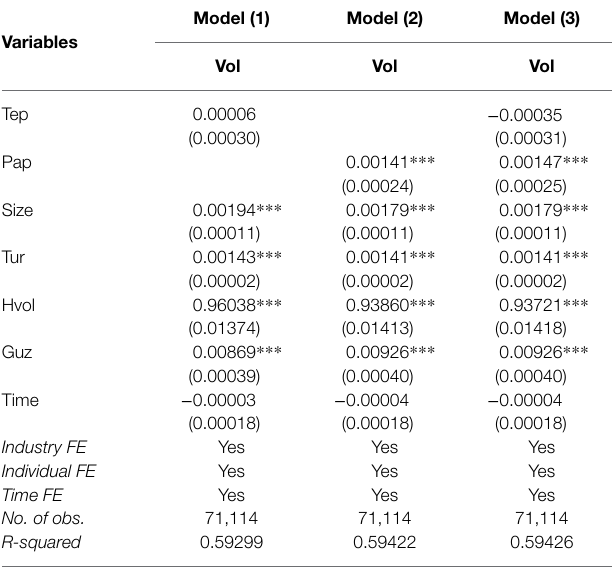
TABLE 4 | Baseline regression results.